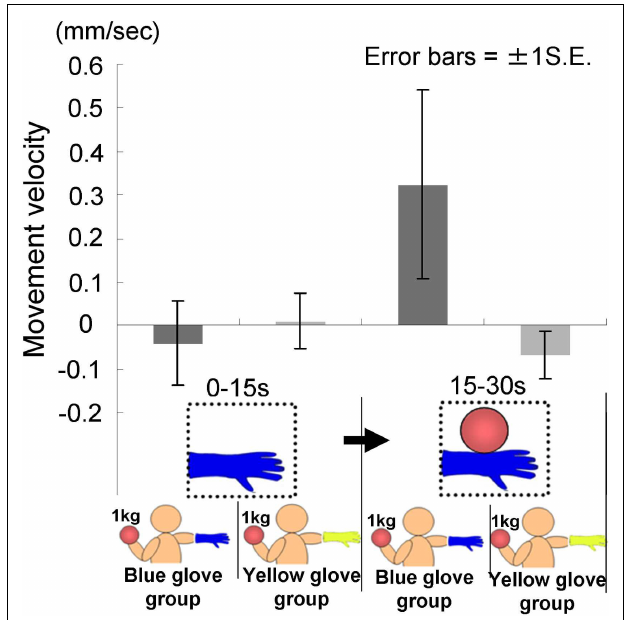
FIGURE 10 | Movement velocity in each group in Experiment